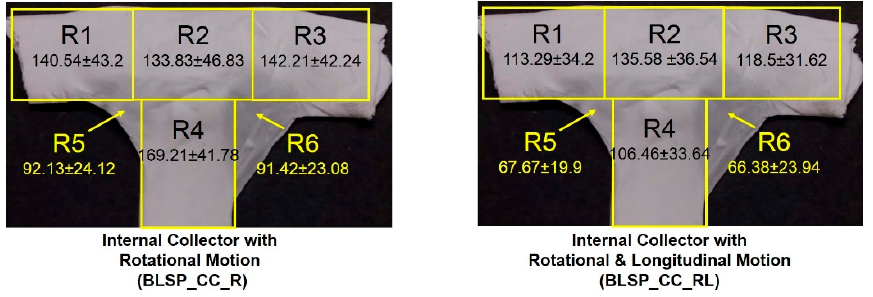
Figure 10. Regions for membrane thickness measurement.